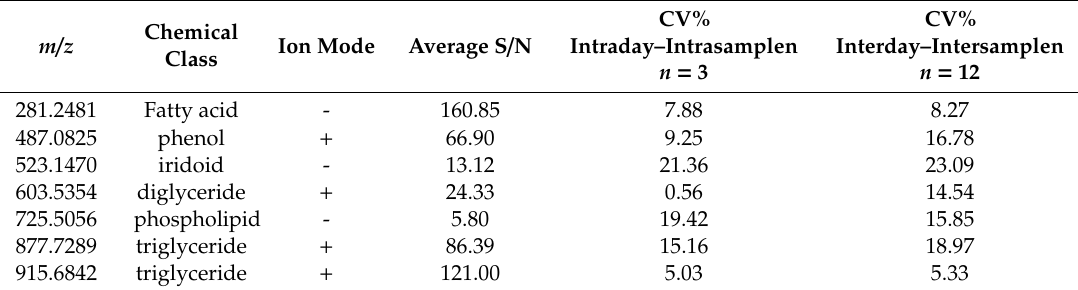
Table 1. Average signal-to-noise (S / N) ratio and relative coe ffi cient of variation (CV%) for 7 ions, at both intra- and interday (two days) levels. The interday CV% was calculated on two di ff erent